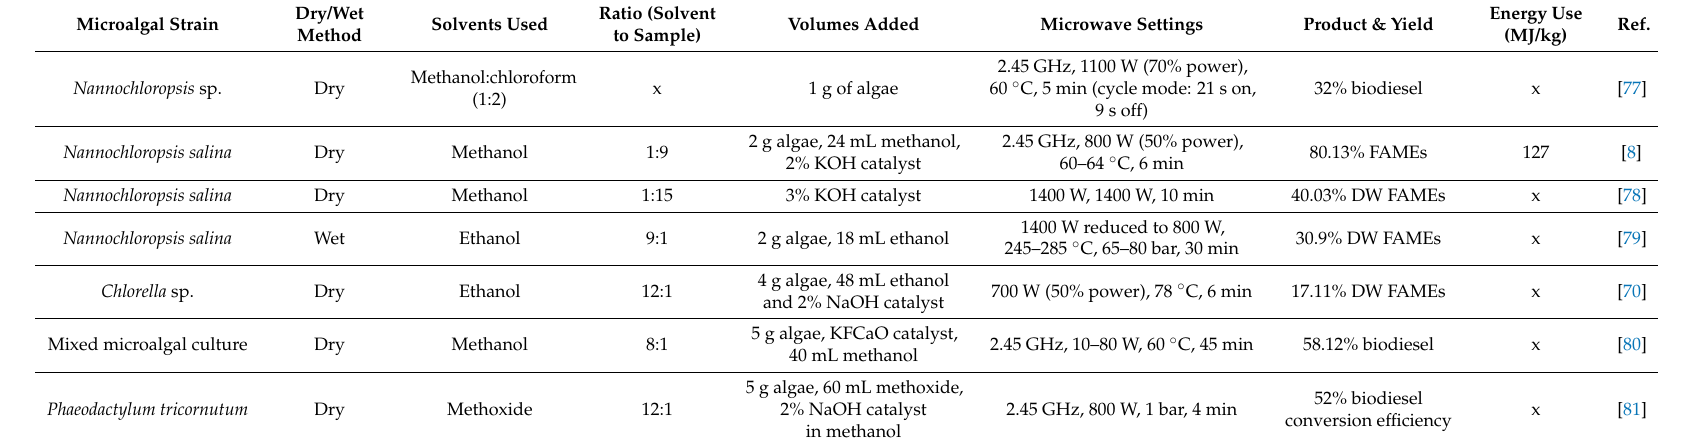
Table 3. Lipids extracted and directly transesterified from microalgae by MW for biodiesel production. Microalgal